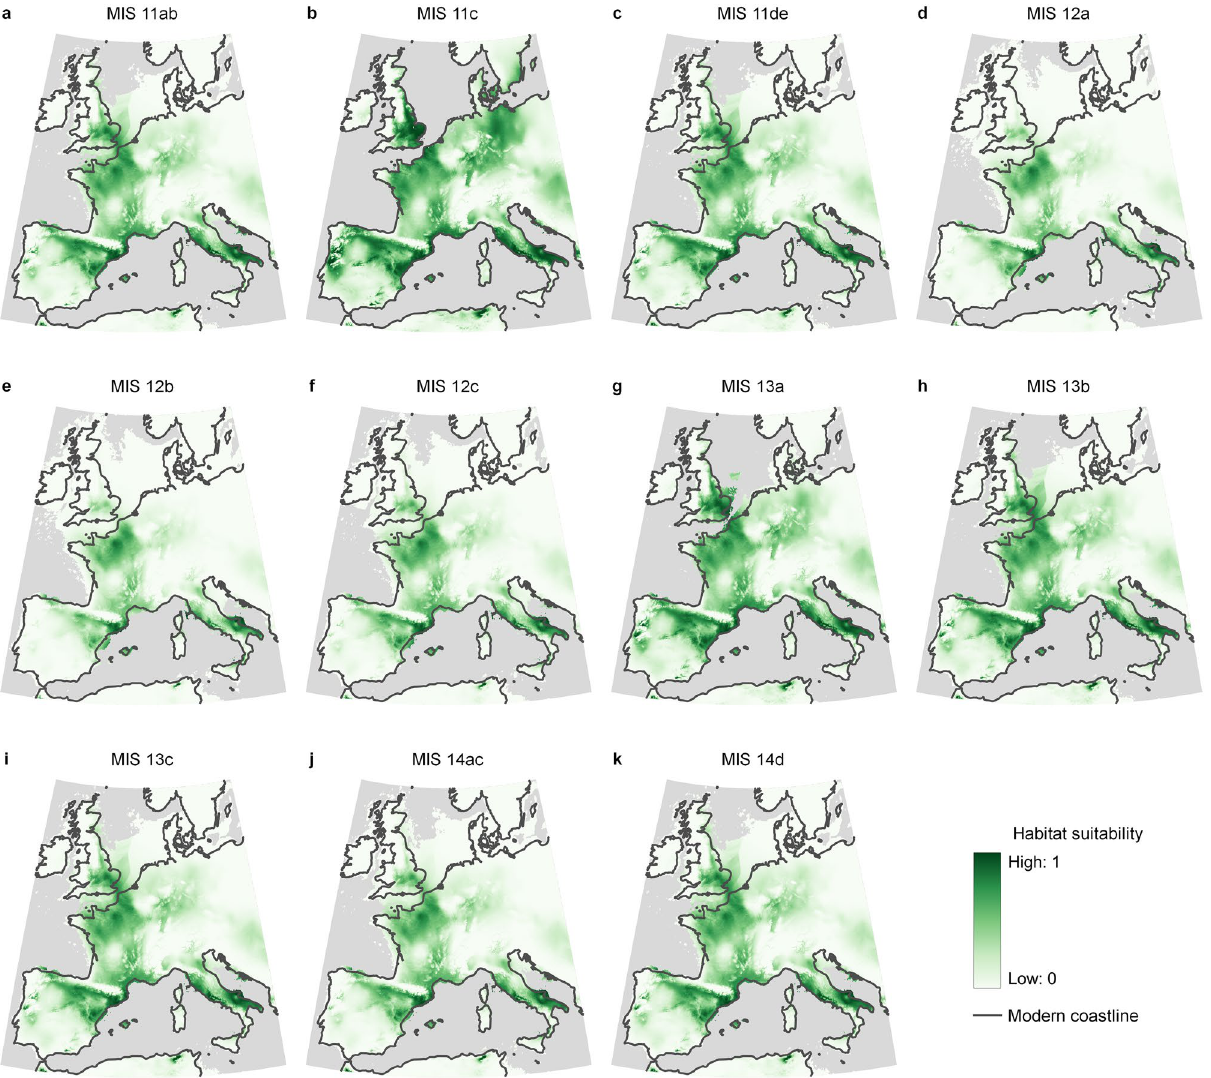
Figure 4. Variation in the area suitable for humans during the MIS14 to MIS11 period. The maps were created in QGIS 3.22 (https:// www. qgis.